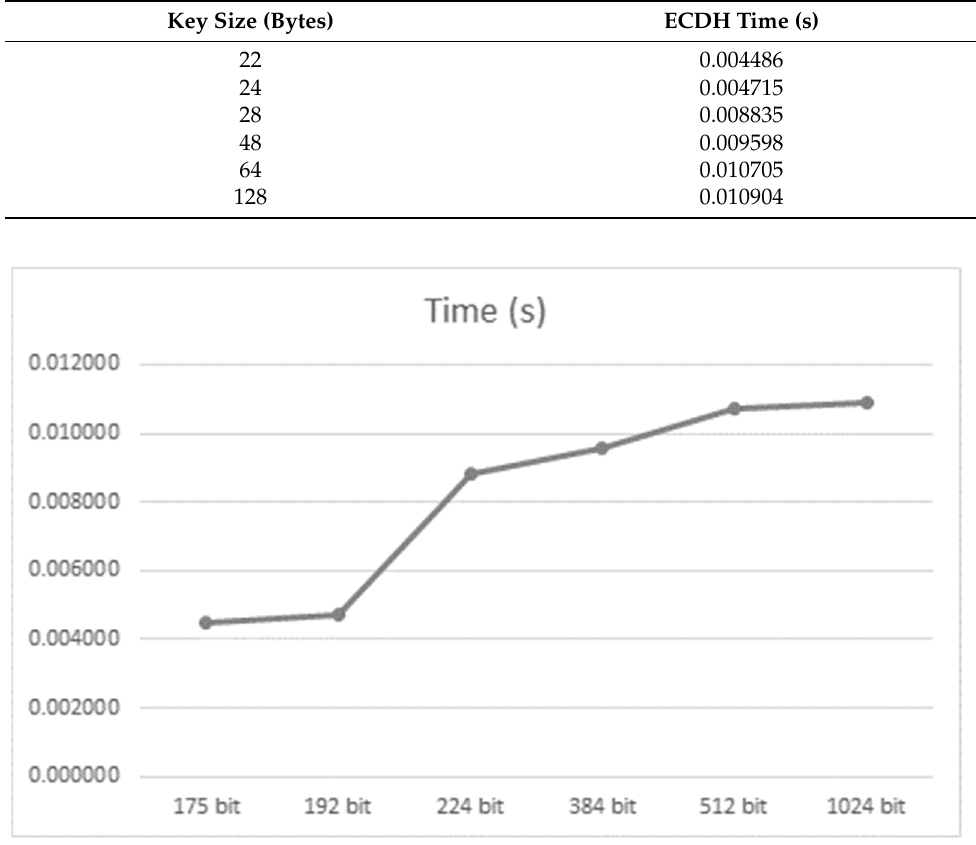
Figure 6. Execution times for corresponding key lengths.